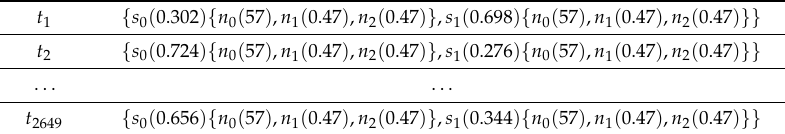
Table 10. Part of the final evaluation vector with a